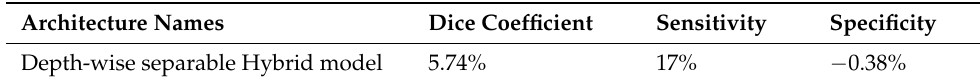
Table 6. Percentage Increase in Performance with respect to Hybrid U-net Architecture.